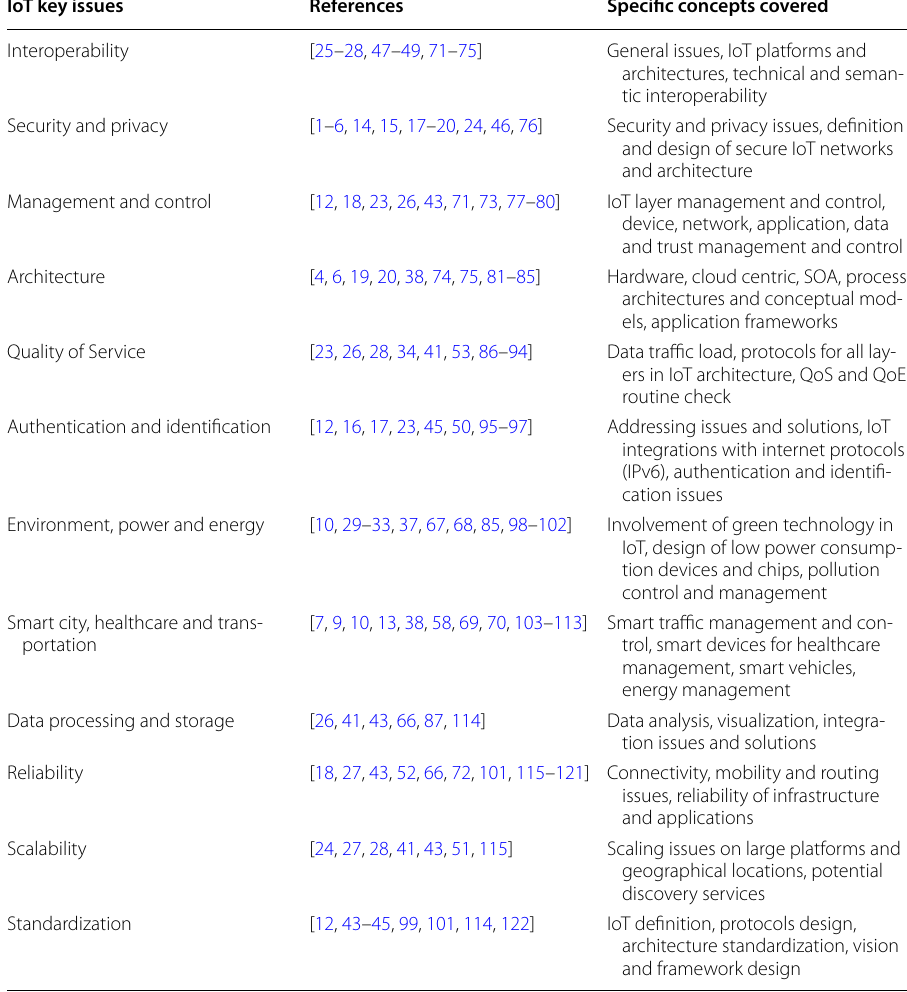
Table 2 A summary of studies with respect to IoT key challenges and applications IoT key